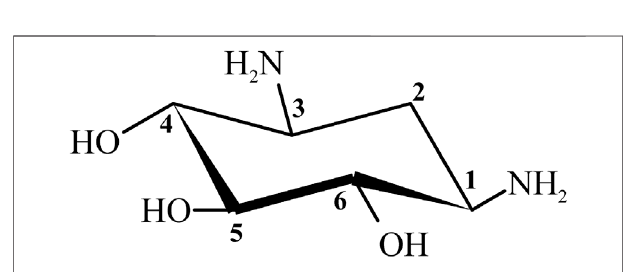
FIGURE 2 | Chemical structure of 2-deoxystreptamine (2-DOS).